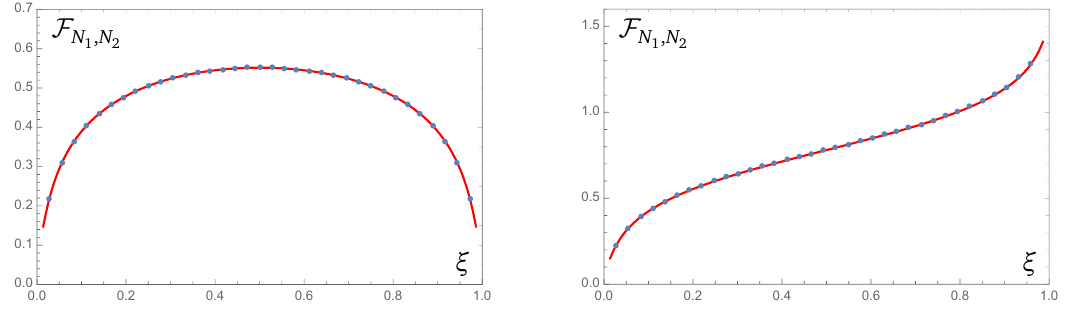
and its approximation 2 , N on 1 2 and odd N on the right panel. The dots 1 2 / N . The solid lines 1